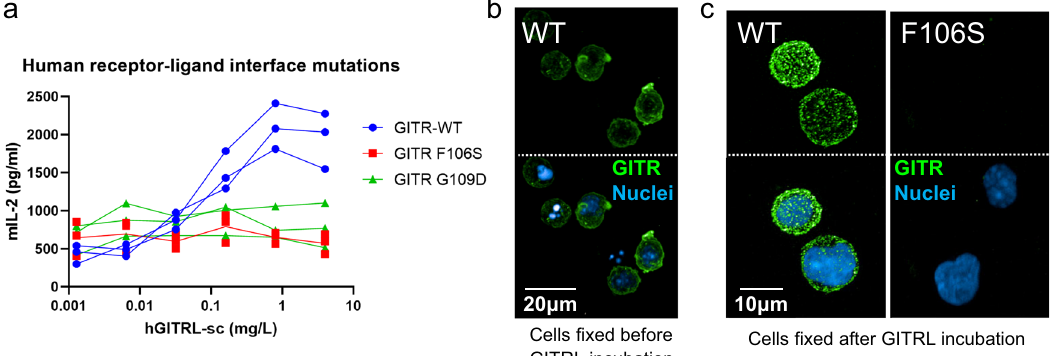
Fig. 6 Human receptor mutations which disrupt the receptor – ligand interface. a mIL-2 secretion upon hGITRL stimulation with hGITR cell lines expressing WT, F106S, or G109D variants ( n = 3; independent experiments performed six times). b Confocal imaging of WT cells fi xed before staining with fl uorescently labeled hGITRL-sc trimers shows diffuse surface GITR. c WT and F106S mutant hGITR expressing cell lines fi xed after staining with fl uorescent hGITRL-sc trimers reveals discrete GITR puncta on WT cell surface, but no hGITRL-sc binding of F106S cells. This imaging experiment was performed once, cells plated in duplicate. Source data are provided as a Source Data fi le.